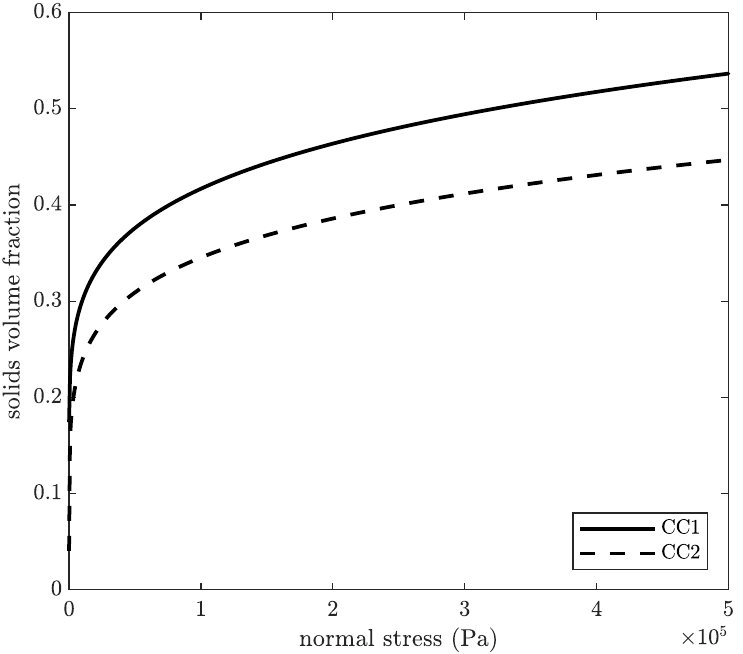
Figure 4. Sediment consolidation function as a function of normal stress for the two used calcium carbonate products.